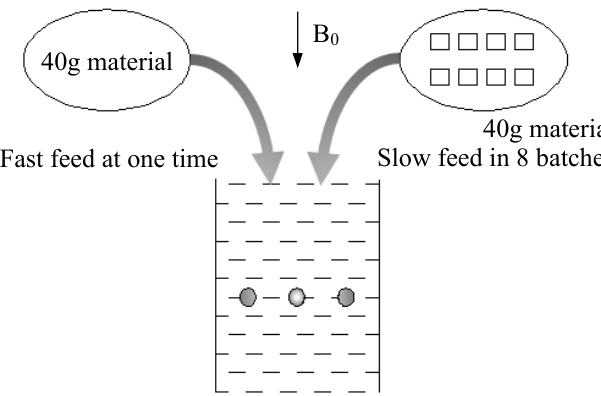
Figure 6. Fast (actual condition) and slow (ideal condition) feed models for material into separating zone.